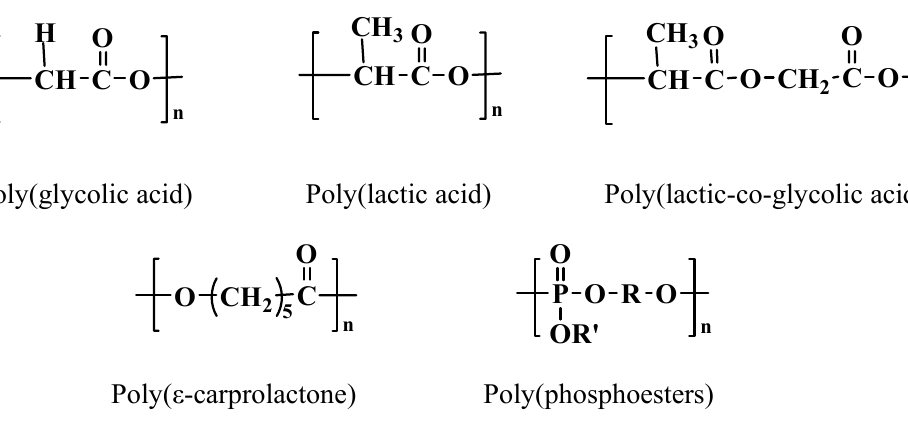
Figure 3. Chemical structures of